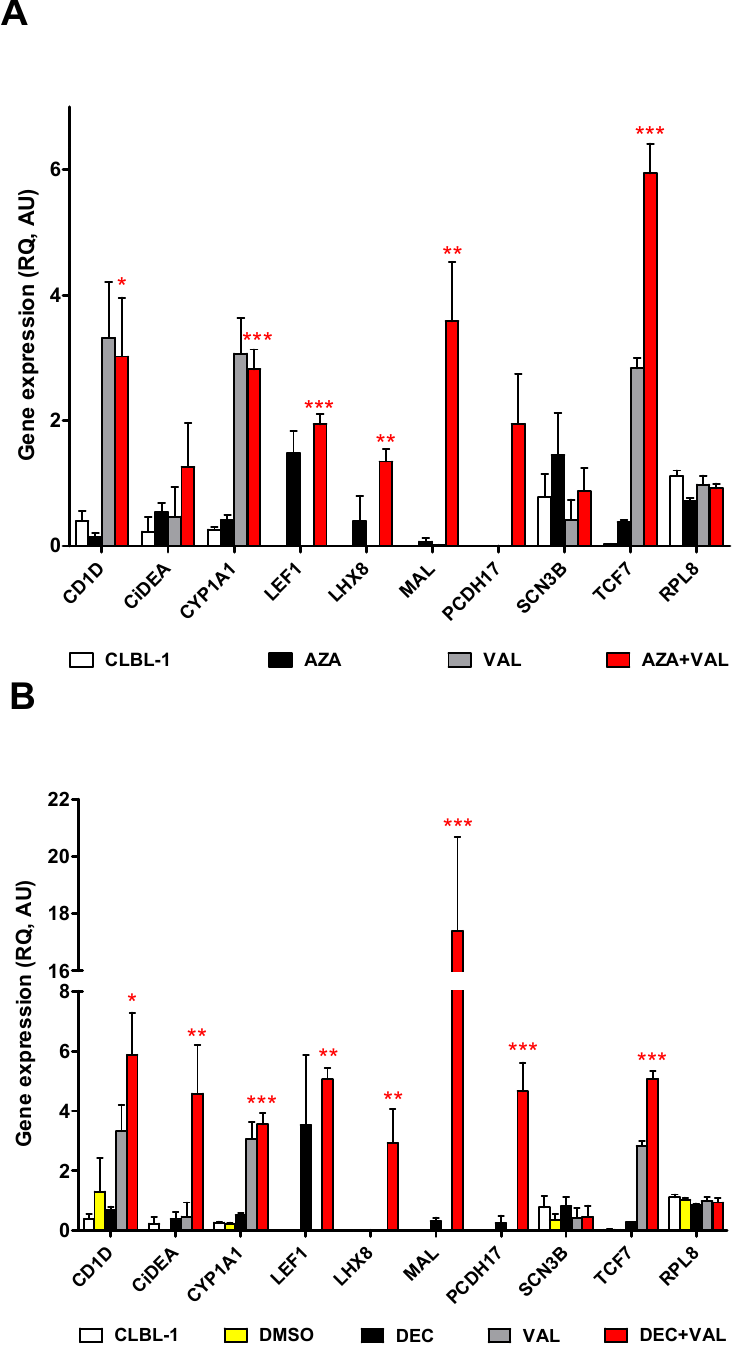
Figure 3. Effect of the treatment with AZA or DEC in combination with VAL on the mRNA expression of 9 candidate TSGs in CLBL-1 cells. ( A ) AZA, ( B ) DEC. The expression levels of the target mRNAs (relative expression values, RQ), evaluated by qPCR and normalized to GOLGA1 and CCZ1 , are expressed in arbitrary units (AU), as the mean ± SEM of four independent experiments. CXCL14, RIPK4 and SLC44A3 are not shown because they were not expressed in CLBL-1 cells both in the control and treatment conditions. RPL8 , the negative control gene, was not affected by the treatment, as expected. Statistical analysis: ANOVA + Bonferroni post hoc test. *: p < 0.05; **: p < 0.01; ***: p < 0.001. The statistical significance between CLBL-1 vs. AZA + VAL and DMSO vs. DEC + VAL only is